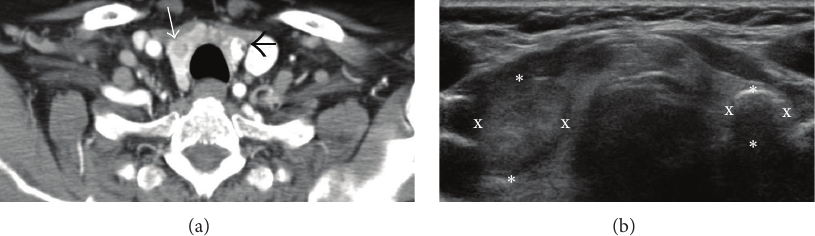
Figure 3: (a) Contrast enhanced computed tomography (CT) of the thorax. Thin, white arrow indicates the largest nodule in the mid pole of the right thyroid lobe, measuring 1.6 × 1.2 × 1.4cm. Black, thick arrow demonstrates a calcified nodule in the mid-to-lower left thyroid lobe measuring 1.1 × 0.9 × 0.9 cm. There are multiple scattered calcified nodules noted throughout the thyroid gland. (b) Axial ultrasound of the thyroid gland. There is evidence of a solid isoechoic nodule in the right thyroid lobe measuring 1.6 × 1.2 × 1.4cm and a peripherally calcified nodule in the left thyroid lobe measuring 1.1 × 0.9 × 0.9